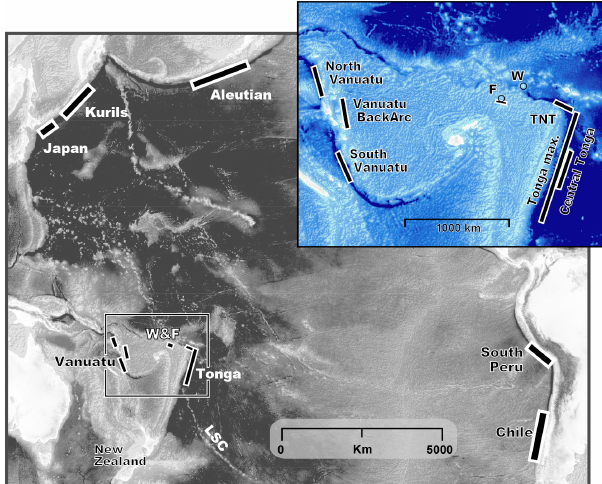
Figure 5. Earthquakes sources (black lines) used in this study tsunami models. Pacific-wide (grey map) and South Pacific (blue map). The lengths and orientations are that used in the models (see Table 4) LSC: Louisville Seamount Chain. Insert: enlargement over the Fiji Basin. W: Wallis; F: Futuna; TNT: Tip North Tonga